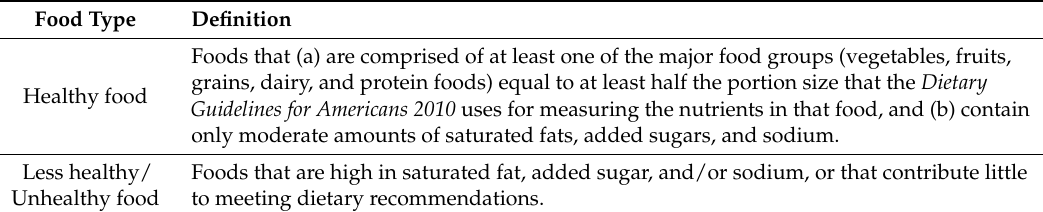
Table 2. Definitions of Healthy vs. Unhealthy Food Items